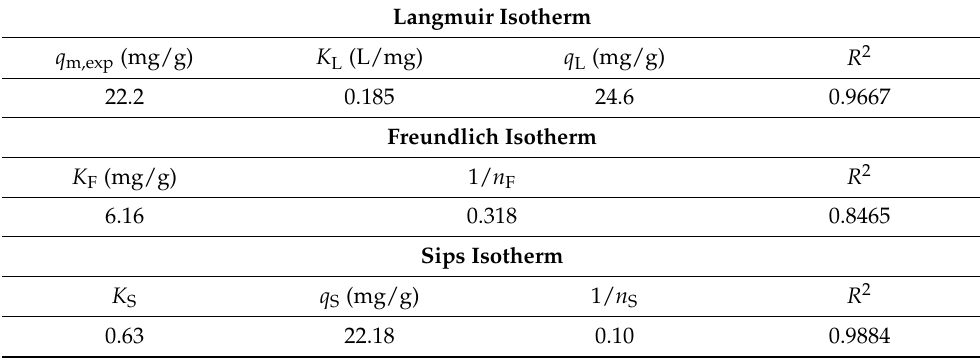
Table 4. Parameters of the isotherm model for the sorption of Au(III) onto the investigated sorbent.